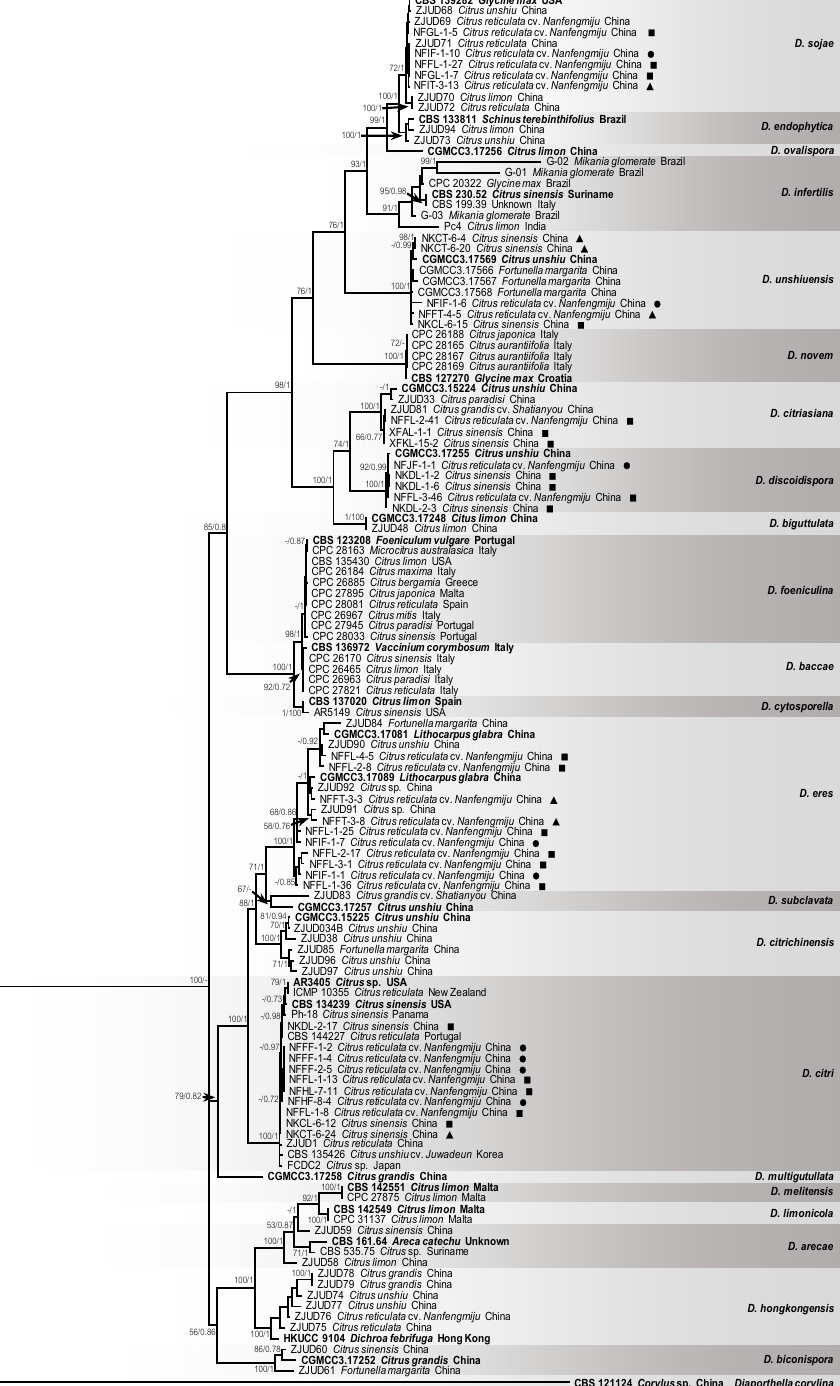
Figure 3. The Bayesian inference consensus tree resulting from a combined data set of ITS, TUB , TEF